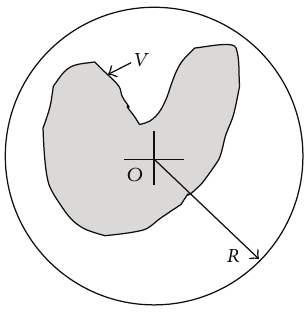
Figure 3: Illustration of an origin 𝑂 for which the support of the source 𝜌 is confined within a ball of radius 𝑅 centered at this